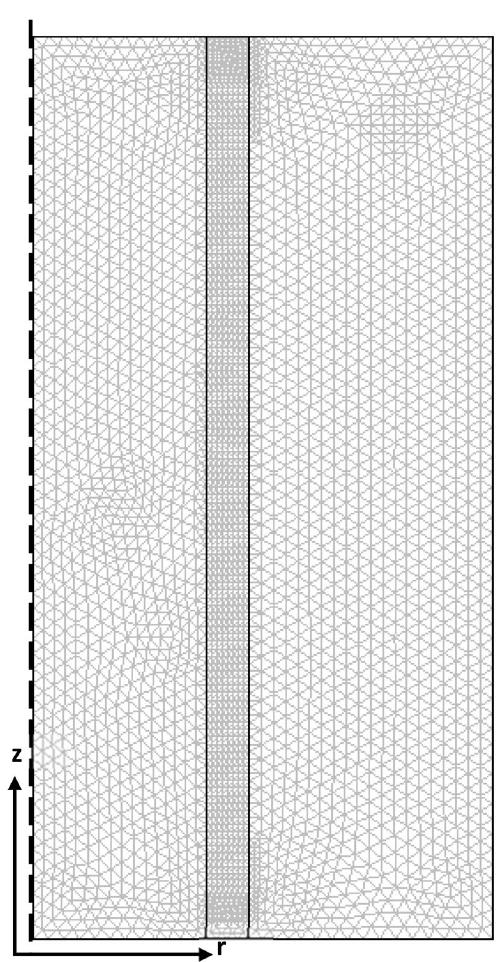
Figure 2. The generated mesh in the membrane